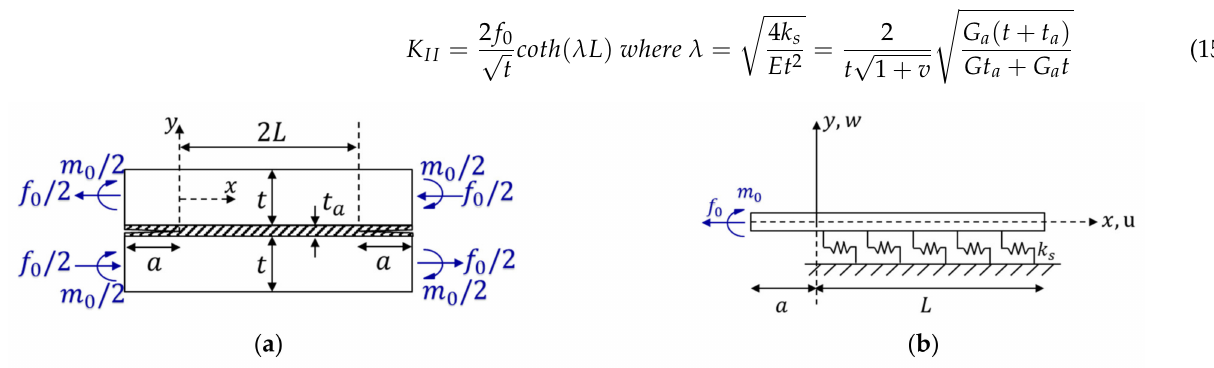
Figure 6. The crack problem definition for Case 3. ( a ) Geometry and load conditions. ( b ) Elastic foundation